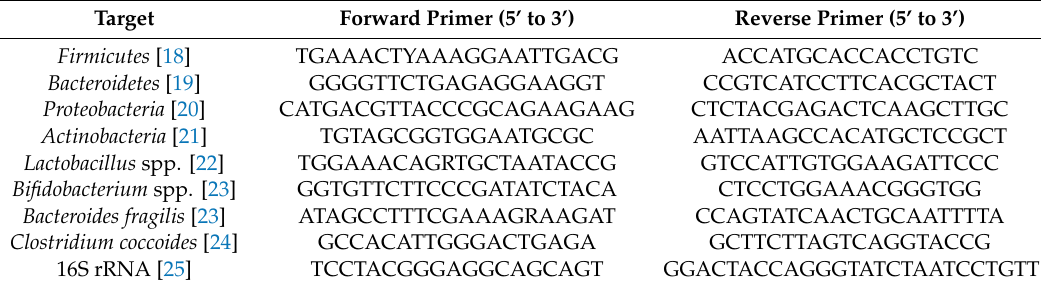
Table 2. Primer sequences used for the gut